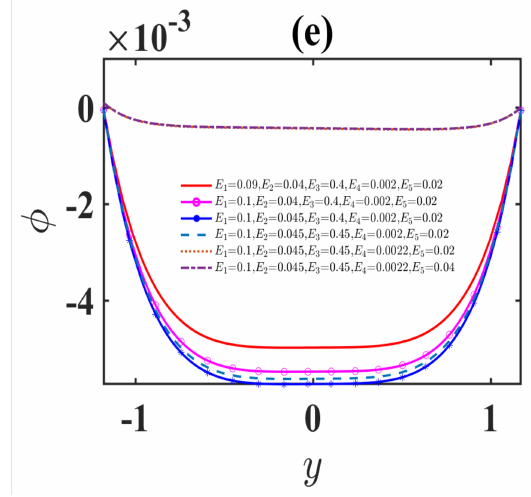
Figure 6. Concentration profiles for varying ( a ) Sr , ( b ) Sc , ( c ) Br , ( d ) m 1 , and ( e ) E 1 − E 5 .